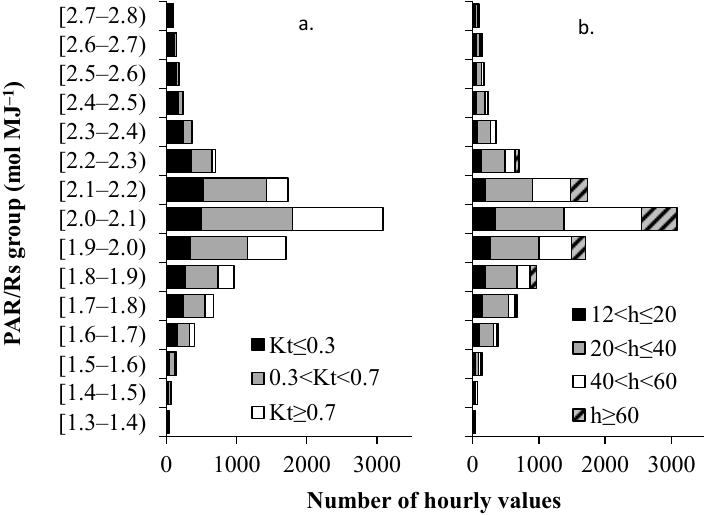
Figure 3. Frequency distribution of the hourly PAR/Rs values according to their magnitude in different ( a ) sky clearness conditions based on the K t index and ( b ) solar inclination angles, h. For the rest of the analyzed parameters that were produced by the filtered dataset used in this study, the general descriptive statistical attributes are presented in Table 1.